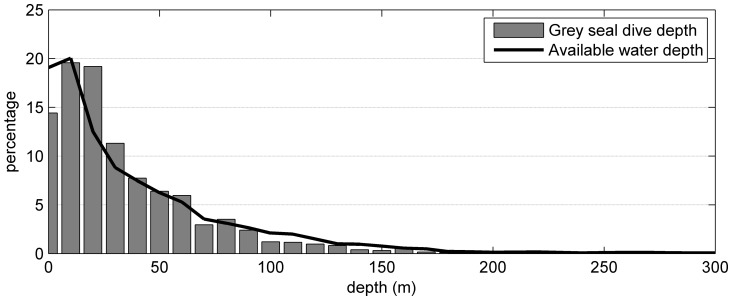
Dive depths of grey seals.Binned dive depths of grey seals based on 223,157 dives (grey bars) and available water depths at 34,140 locations (black line) from the ETOPO1 1 arc-minute global relief model.